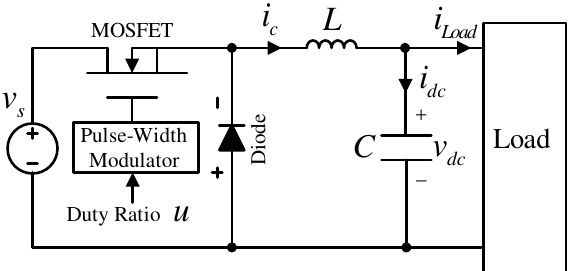
Figure 2. DC/DC buck converter